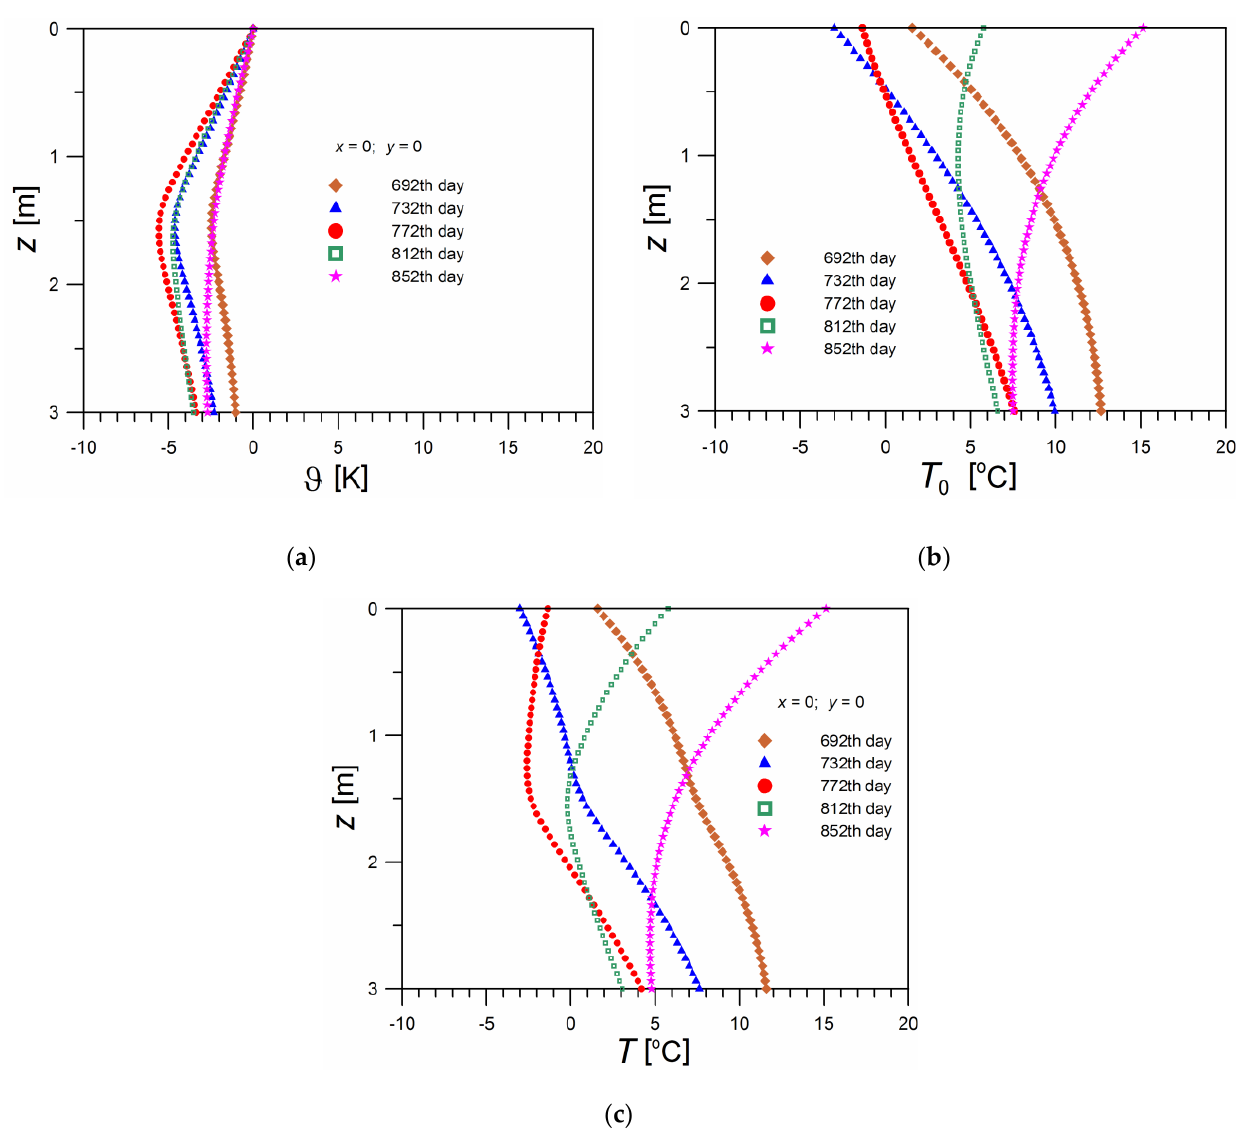
Figure 10. Ground temperature profiles along the z axis: ( a ) temperature response caused by the heat source, ( b ) undisturbed ground temperature, ( c ) ground temperature.